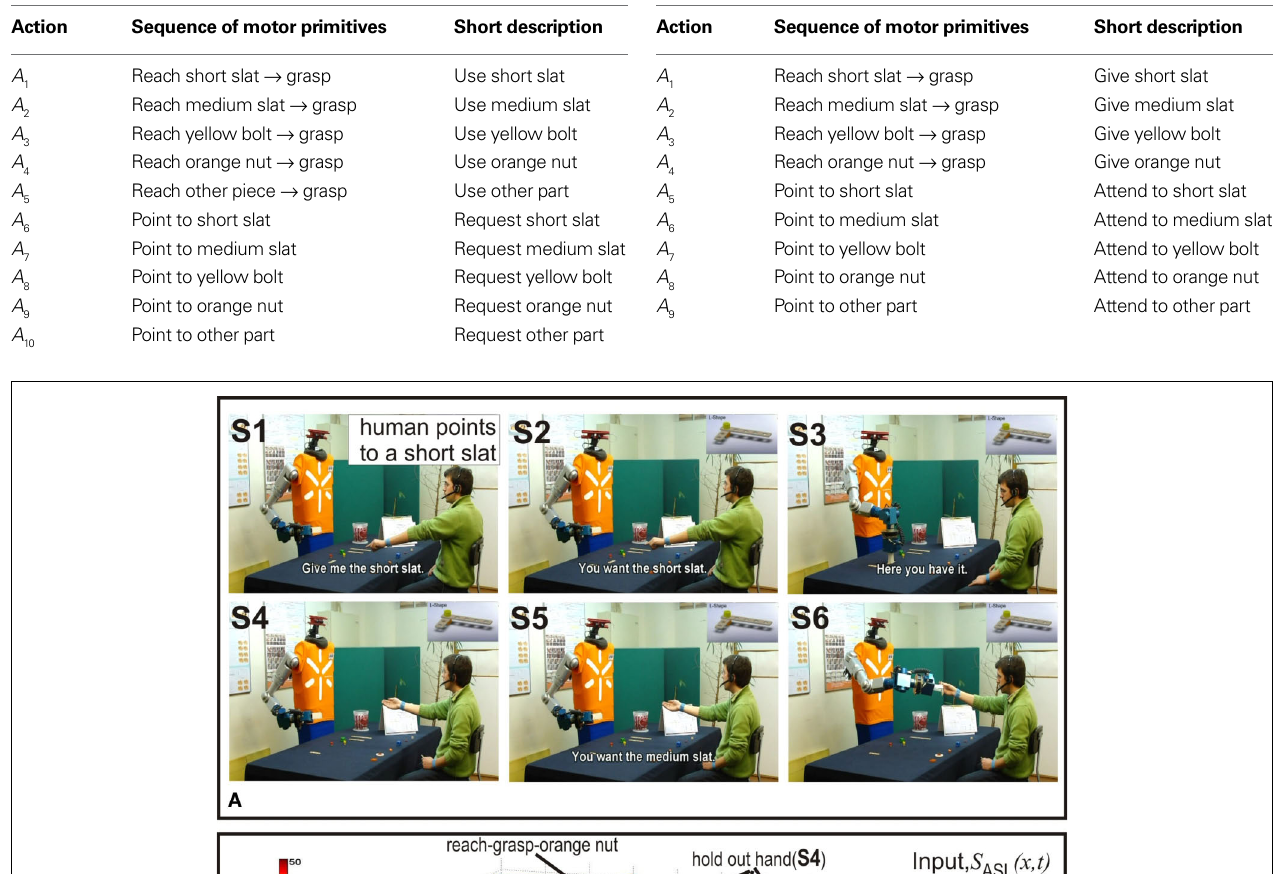
Table 2 | Goal-directed sequences and communicative gestures in AEL.